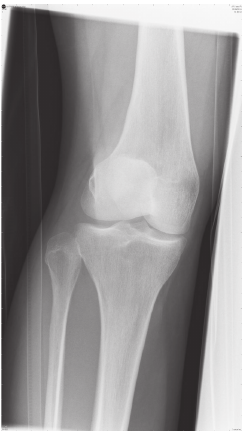
Figure 1: Anterior-posterior view of the patients’ knee with the characteristic “dorsal fin” appearance of tenting of the skin over the laterally displaced patella.